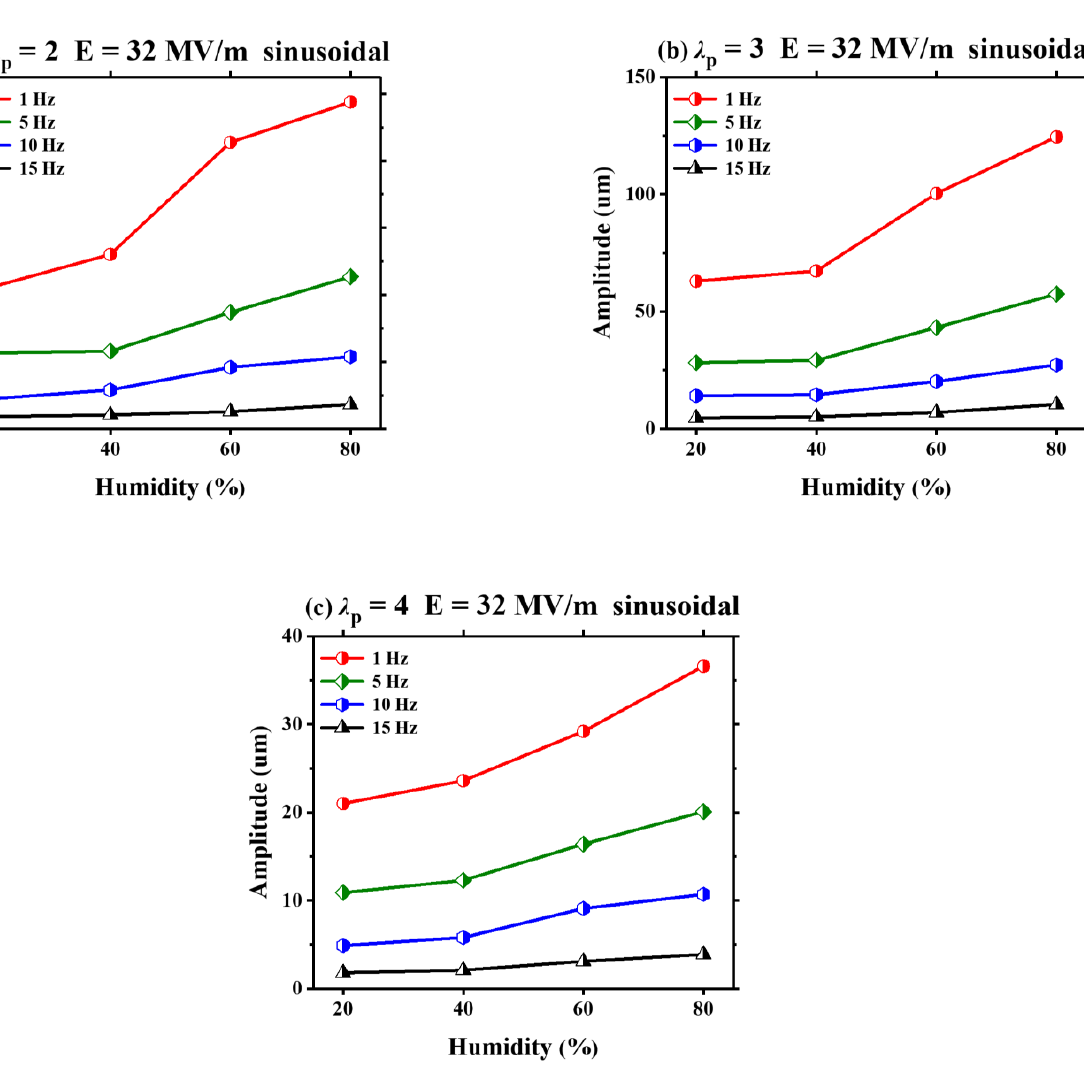
Figure 7. Under different pre-stretch ratios ( λ p = 2, λ p = 3, λ p = 4), the humidity effect on the amplitude of the VHB 4905 film with different frequencies (1Hz, 5Hz, 10Hz, 15Hz).